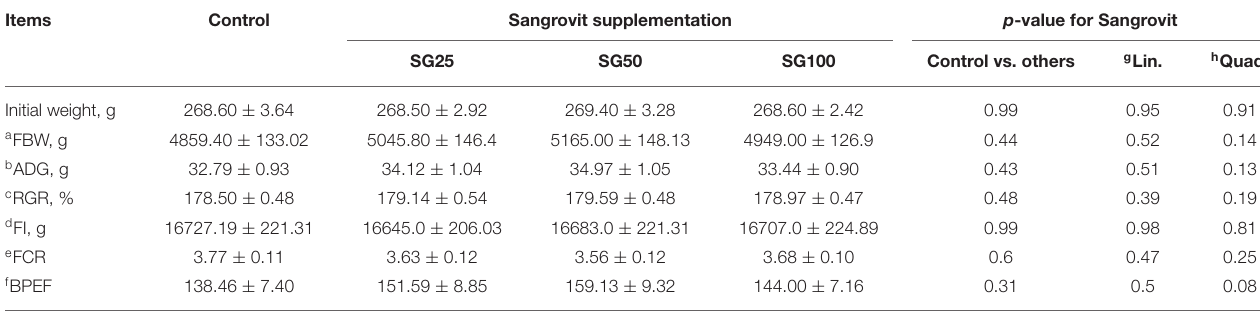
TABLE 3 | Effect of Macleaya cordata dietary supplementation on growth performance of